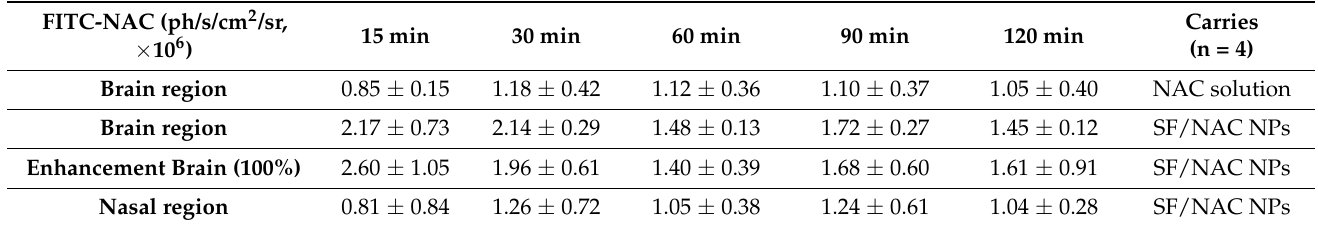
Table 2. The intensities of fluorescence of FITC-NAC that were delivered to the brains, and retained in the nasal cavities of rats for nasal delivery using SF/ FITC-NAC NPs as carriers or FITC-NAC solutions for 2 h were presented by an IVIS study. The fluorescent intensity in the nasal cavity for varying times was not different to that for t = 0 if delivery used NAC solutions (n = 4). All data were presented as mean ± sd., (n =